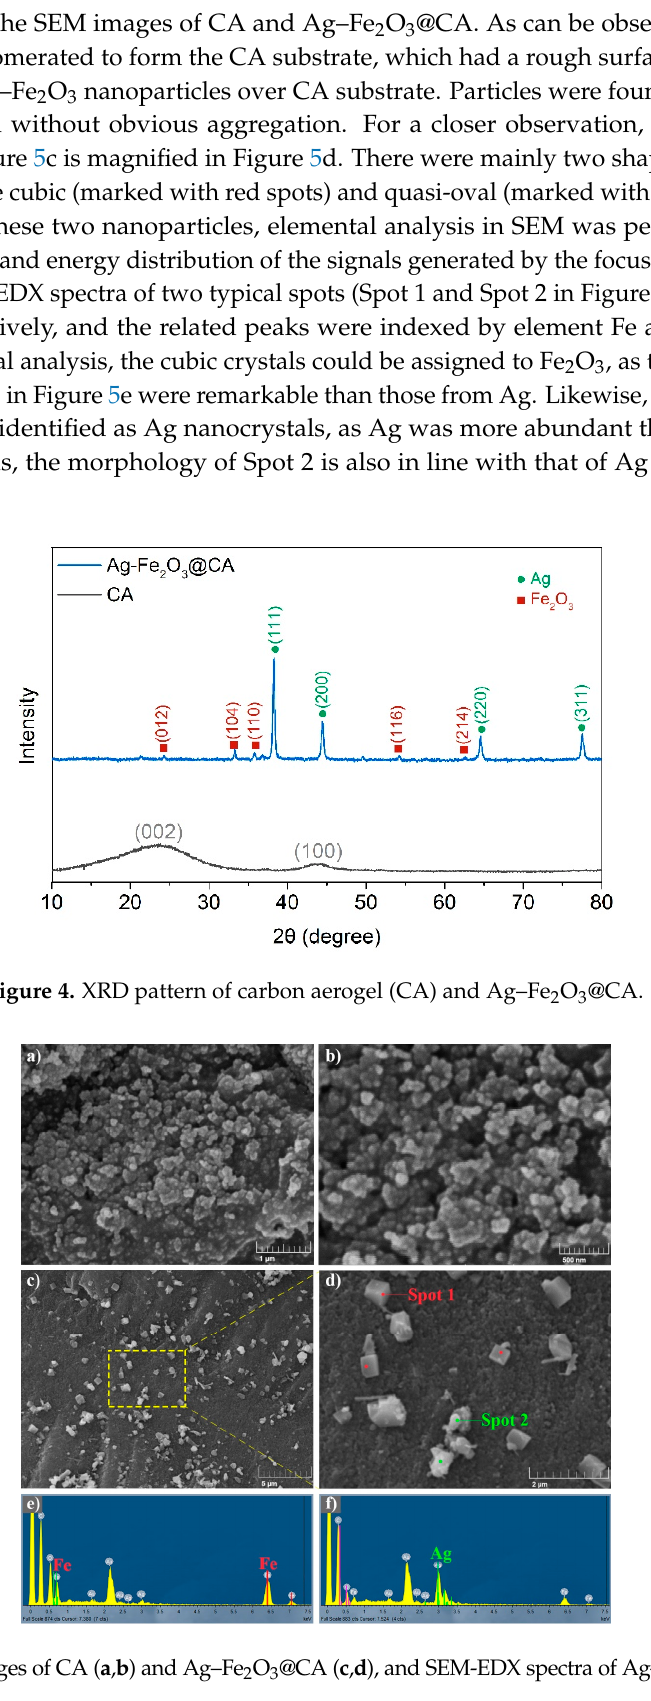
Figure 6. TEM images of Ag-Fe 2 O 3 @CA; ( a ): Fe 2 O 3 nanoparticle; ( b , c,d ): Ag nanoparticles of various sizes.